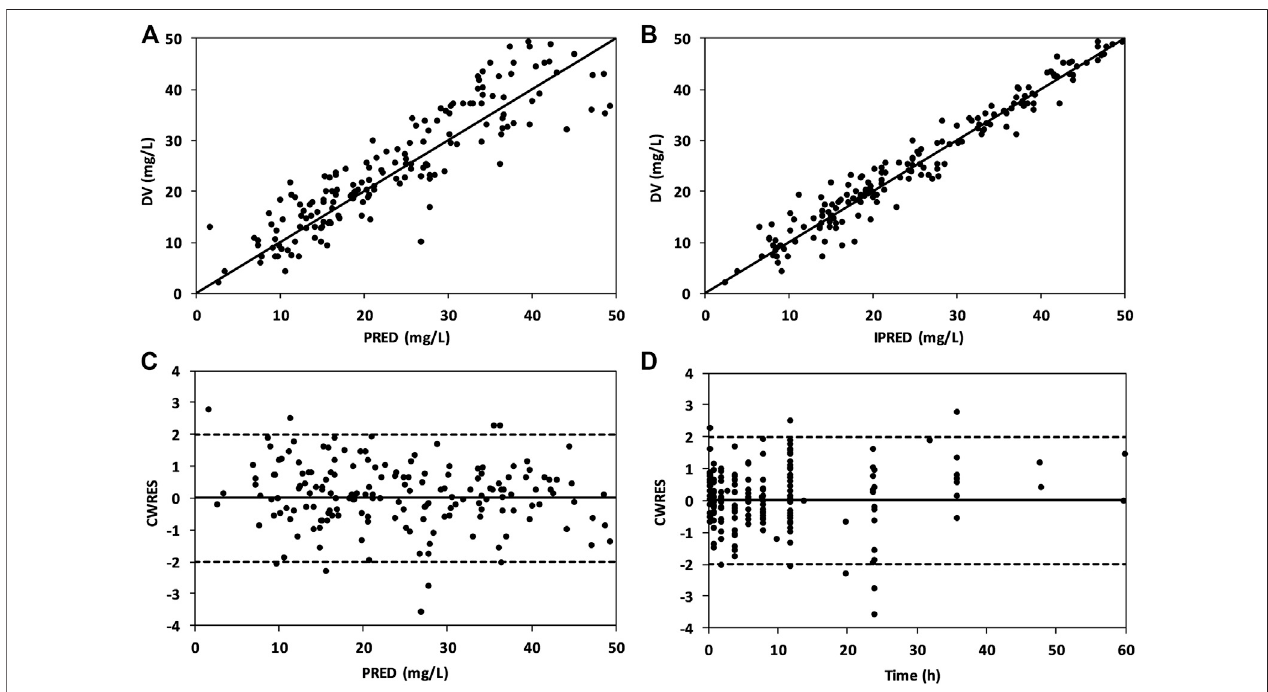
FIGURE 3 | Goodness-of- fi t plots of the fi nal model showing DV vs. PRED (A) , DV vs. IPRED (B) , CWRES vs. PRED (C) , and CWRES vs. time after dose (D) .